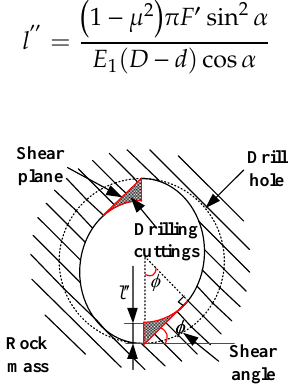
Figure 5. A schematic diagram of the force of the end face of I-I.